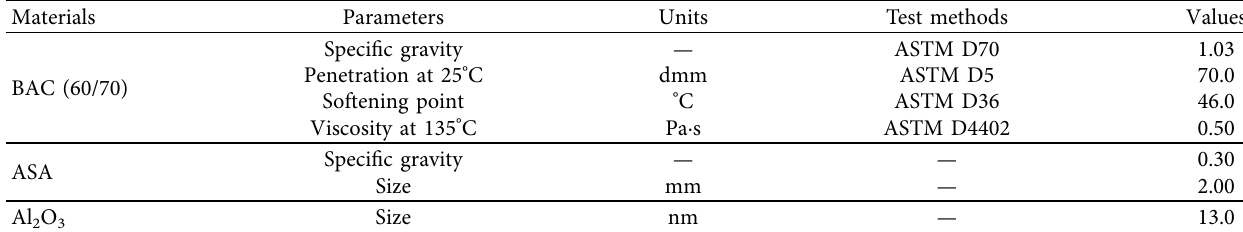
Table 1: Physical properties of the base AC, ASA, and Al